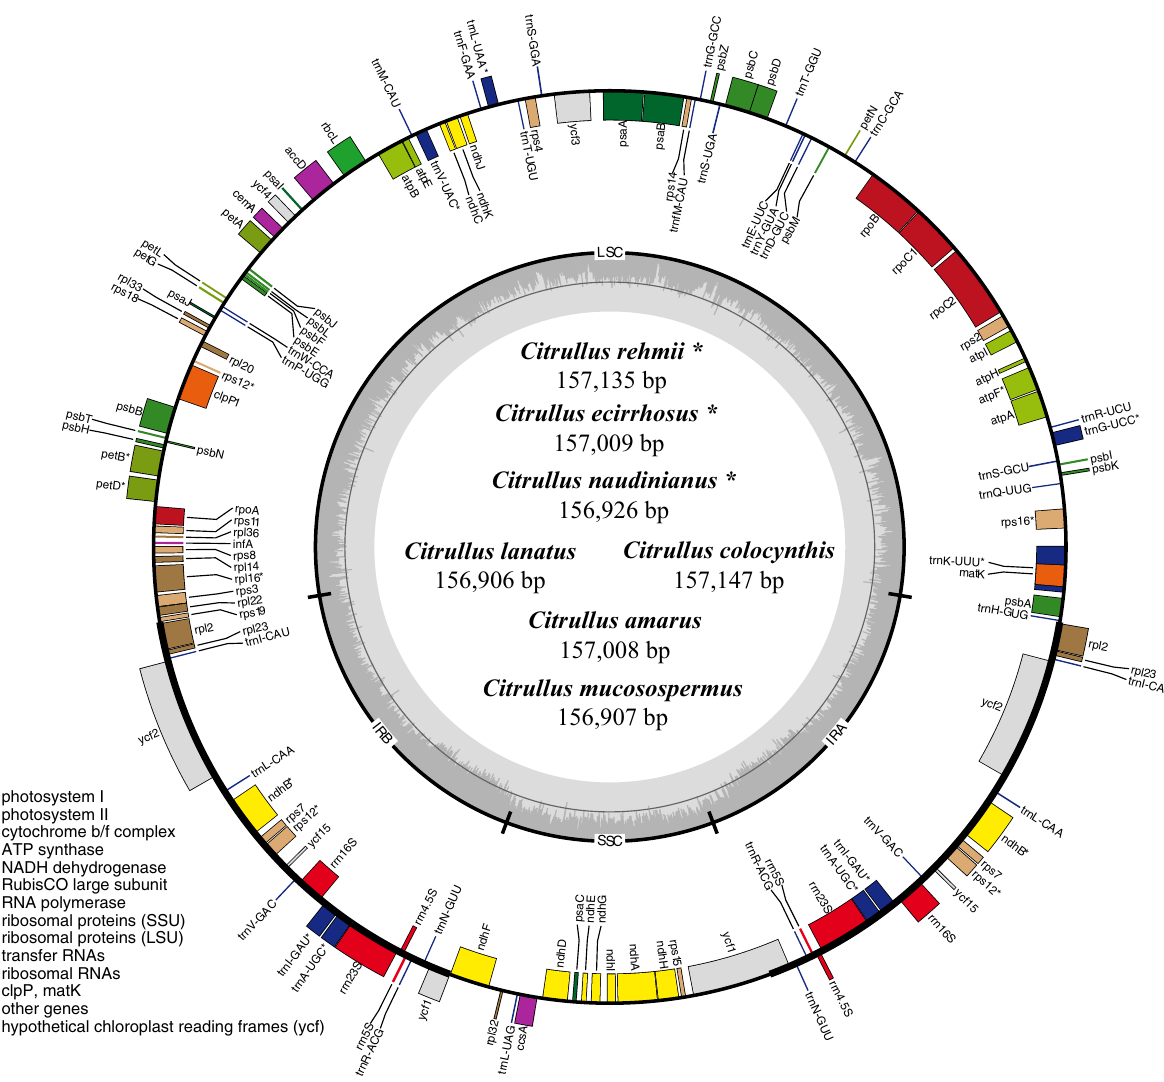
Figure 1. Complete chloroplast genome circle map of the seven studied Citrullus species. Genes outside the circle are transcribed on the positive chain, whereas those genes inside the circle are transcribed on the negative chain. Boxes with different colors represent genes with a different functional group. The inner ring shows the positions of LSC, IRa, SSC, and IRb, with the GC clamp of the chloroplast genome shown in grey. The chloroplast genome map was draw using OGDRAW v1.3.1 (https:// chlor obox. mpimp- golm. mpg. de/ OGDraw.